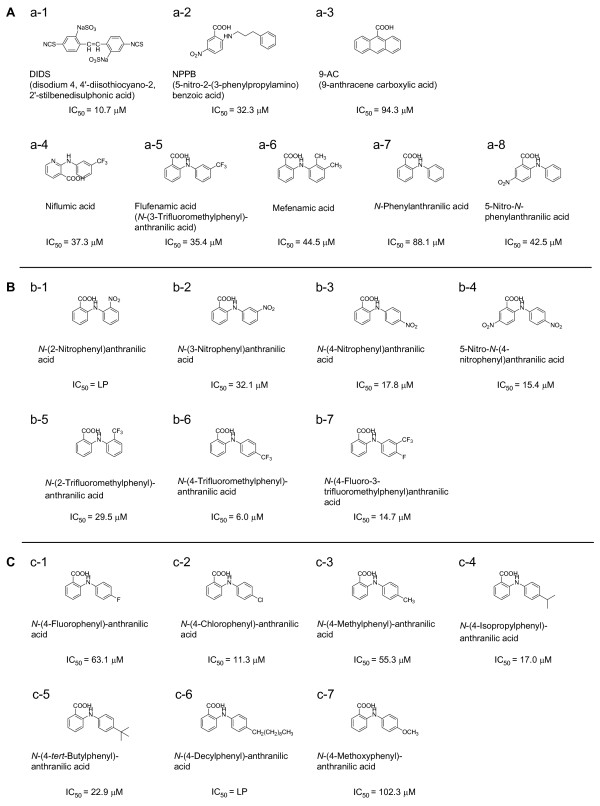
Chemical structures and IC50s of known blockers and anthranilic acid derivatives. (A) Known blockers. (B) Anthranilic acid derivatives; positional compounds. (C) Anthranilic acid derivatives that have variable substituent group on para position of benzene ring. LP: Low Potency. IC50 > 200 μM. n indicates number of oocytes.